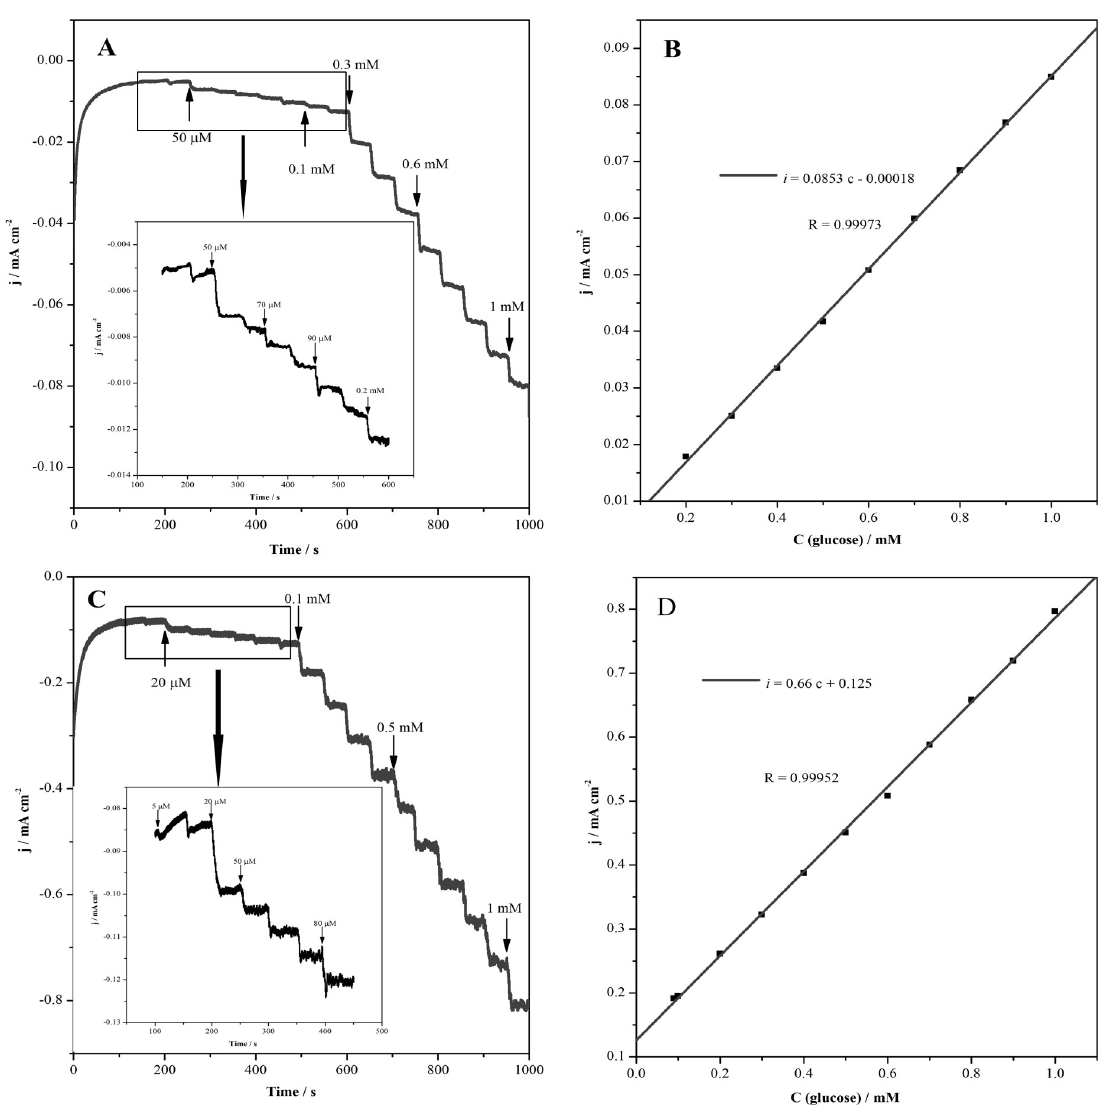
Fig 6. The response of Cu@Ni CSNPs/Nafion/GCE and Cu@Ni CSNPs/N-GQDs/Nafion/GCE towards glucose. Current-time responses at +0.6 V with an increasing glucose concentration every 50 s for the Cu@Ni CSNPs/Nafion/GCE ( A ) and the linear relationship between the catalytic current and glucose concentration ( B ); Cu@Ni CSNPs/N-GQDs/Nafion/GCE ( C ) and the linear relationship between the catalytic current and glucose concentration ( D ). https://doi.org/10.1371/journal.pone.0220005.g006 Fig, 0.5 mM glucose, 0.1 mM DA, 0.1 mM AA, 0.1 mM UA, 0.1 mM NaCl and 0.5 mM glucose were detected by Cu@Ni CSNPs/N-GQDs/Nafion/GCE at +0.6 V. Furthermore, other sugars may also affect the determination of glucose, such as sucrose, fructose, D-galactose, maltose, and so on. As shown in S5A and S5B Fig, 0.5 mM glucose, 0.1 mM maltose, 0.1 mM sucrose, 0.1 mM fructose, 0.1 mM D-galactose and 0.5 mM glucose were detected by Cu@Ni CSNPs/ N-GQDs/Nafion/GCE at +0.6 V. The experimental results show that the current response of the interference components is very weak, indicating that low levels of sugar have very little affect for the glucose determination. Cu@Ni CSNPs/N-GQDs/Nafion/GCE has high selectivity for glucose determination.